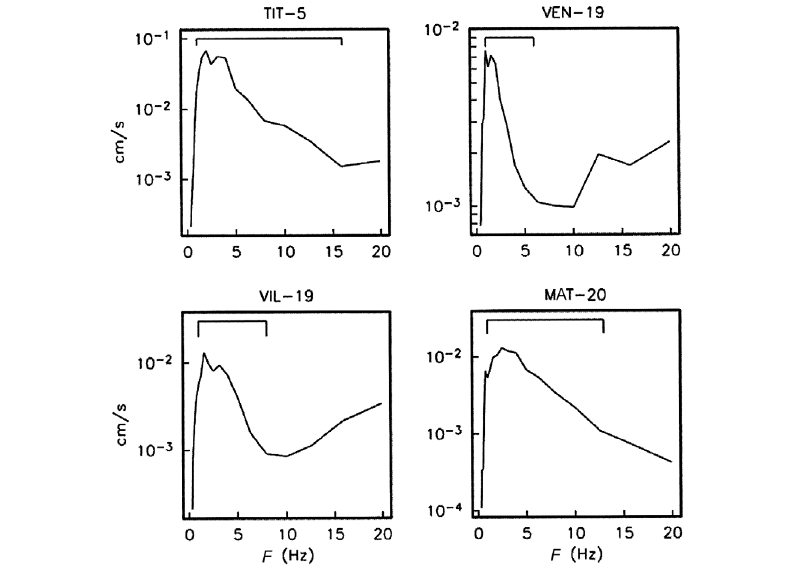
Fig. 3. Examples of acceleration spectra and the frequency band used. The frequency band used for further analysis is shown with